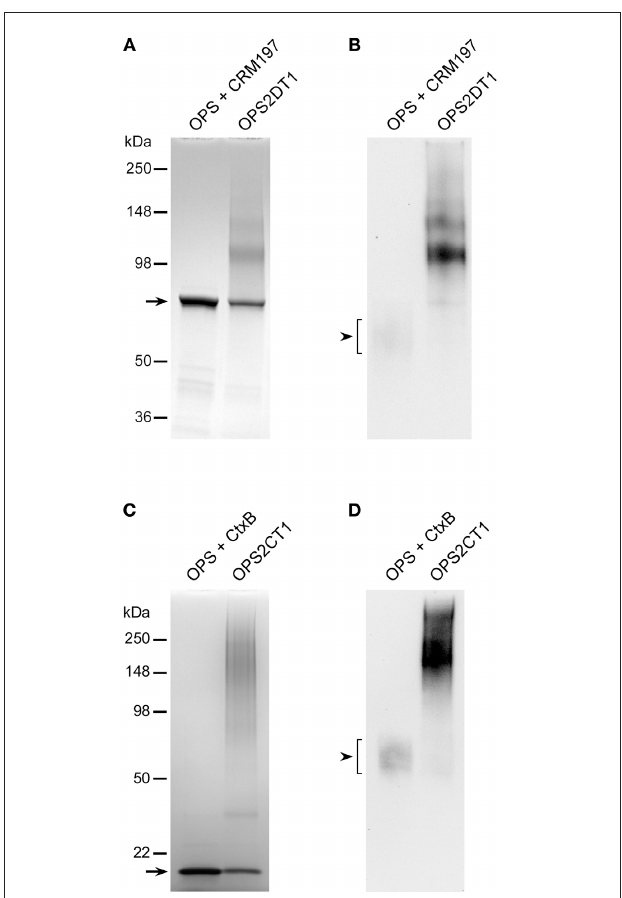
FIGURE 6 | Physical analysis of B. thailandensis OPS-CRM197 and OPS-CtxB glycoconjugates. (A and C) SDS-PAGE and Coomassie Blue staining was used to confirm the covalent linkage of ZT0715 OPS to CRM197 or CtxB. The OPS + CRM197 or CtxB lanes represent unconjugated controls. The black arrows indicate the positions of the CRM197 or CtxB bands. The positions of protein molecular size standards are indicated on the left. (B and D) Western immunoblotting was also used to assess the antigenicity of the chemically activated/coupled ZT0715 OPS. OPS was detected using the 3D11mAb. The black arrowheads indicate the positions of the OPS which binds poorly to the membranes when